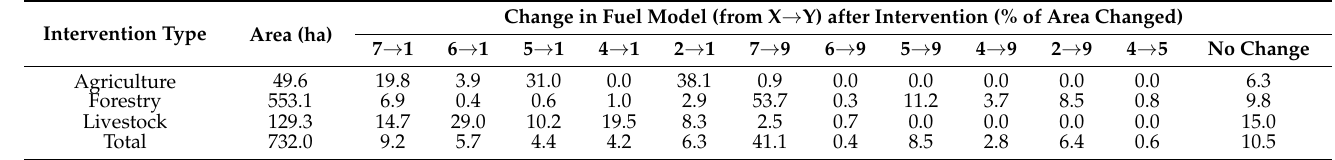
Table 8. Changes in fuel model after implementation of project interventions (% of area